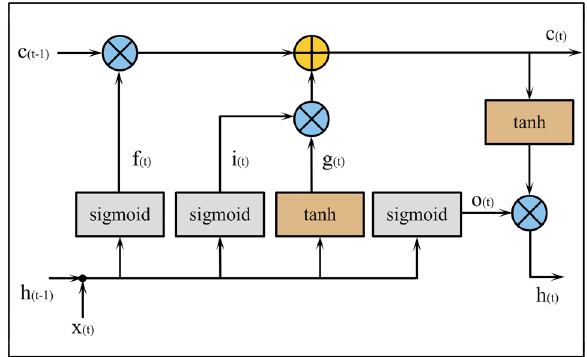
Fig. 5 Generic configuration of a long-short term memory (LSTM) cell (see text for definition of each symbol)